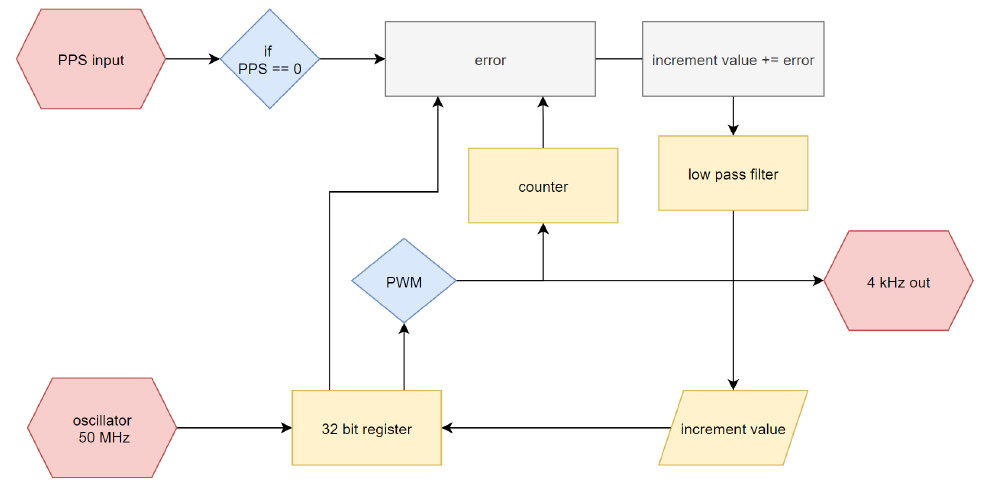
Figure 2. PPS-disciplined digital oscillator implemented in FPGA.